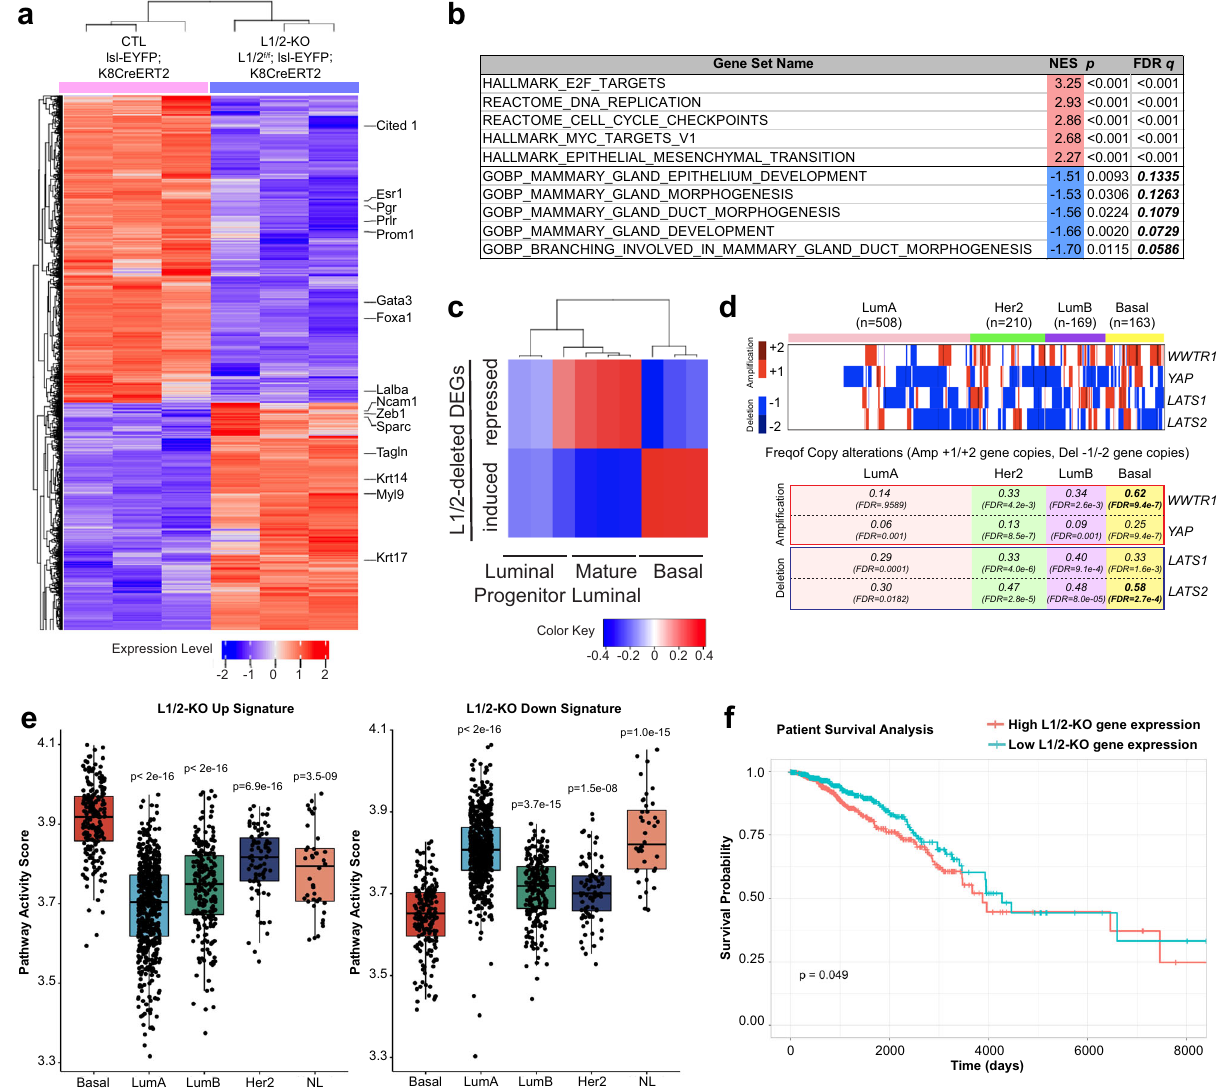
Fig. 4 | Luminal LATS1/2 loss promotes a basal-like transcriptional program phenocopying human basal-like breast cancer. a Heatmap of gene expression changes in EYFP+ mammary cells sorted from Lats1/2 f/f ;lsl-EYFP;K8CreERT2 mice compared to lsl-EYFP;K8CreERT2 control mice as analyzed by RNA-sequencing ( n =3 per condition, 2-fold change and FDR<0.05 cutoff). b Selected GSEA- generated genesets enriched in the upregulated (red) and downregulated (blue) signatures of LATS1/2-null cells compared to control. c GSVA analysis comparing the upregulated and downregulated signatures of LATS1/2-null cells to those of normal mammary luminal mature, luminal progenitor, and basal cells (GSE63310). d Analysis of copy number alterations of Hippo pathway-related factors in human breast cancers. Heatmaprepresenting one or two alleledeletions or ampli fi cations are shown on top and the frequency of these alterations in the different breast cancer subtypes are shown at the bottom. e Activity levels of the LATS-up/